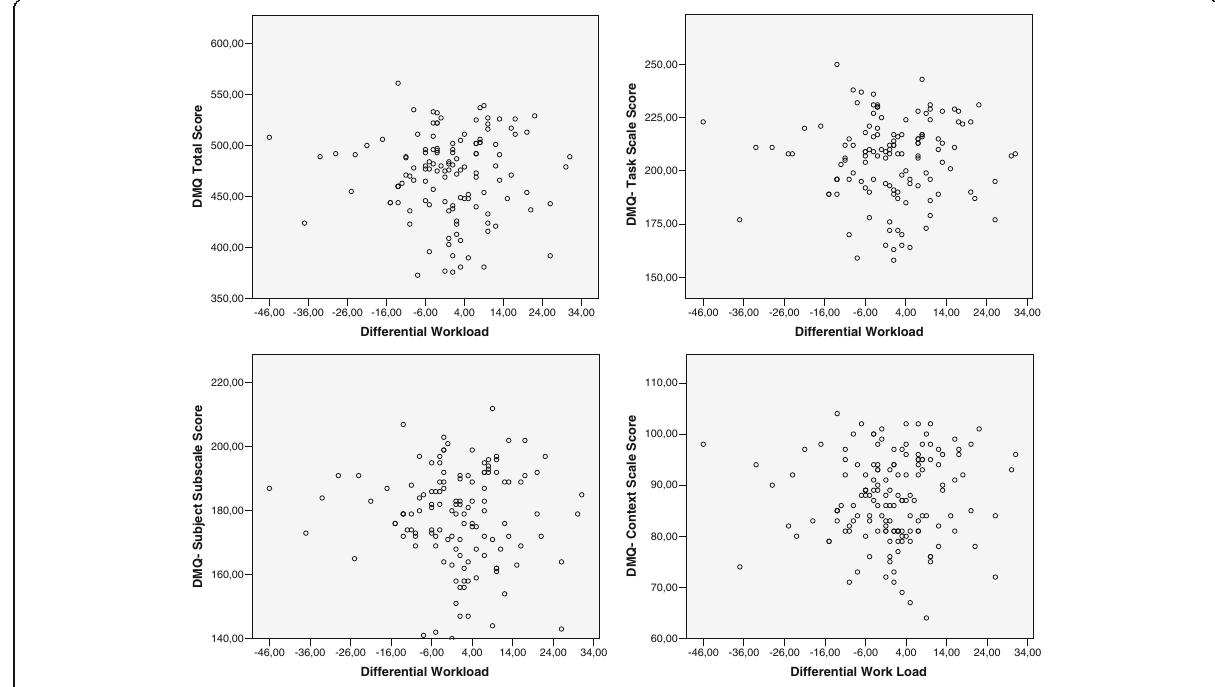
Fig. 3 Scatter plots. DMQ vs. Differential Workload. DMQ Decision-Making